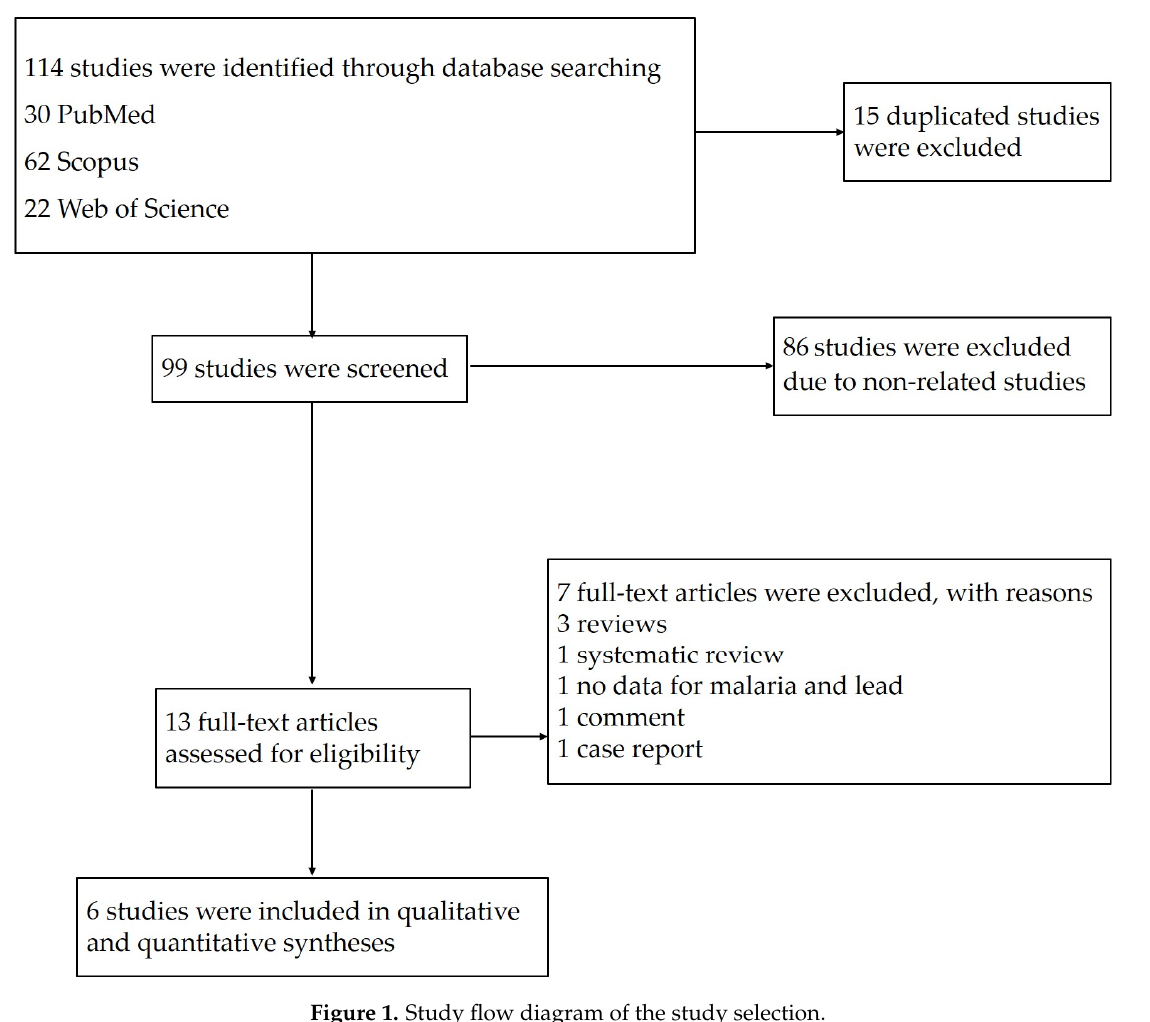
Figure 1 . Study flow diagram of the study selection . Figure 1. Study flow diagram of the study